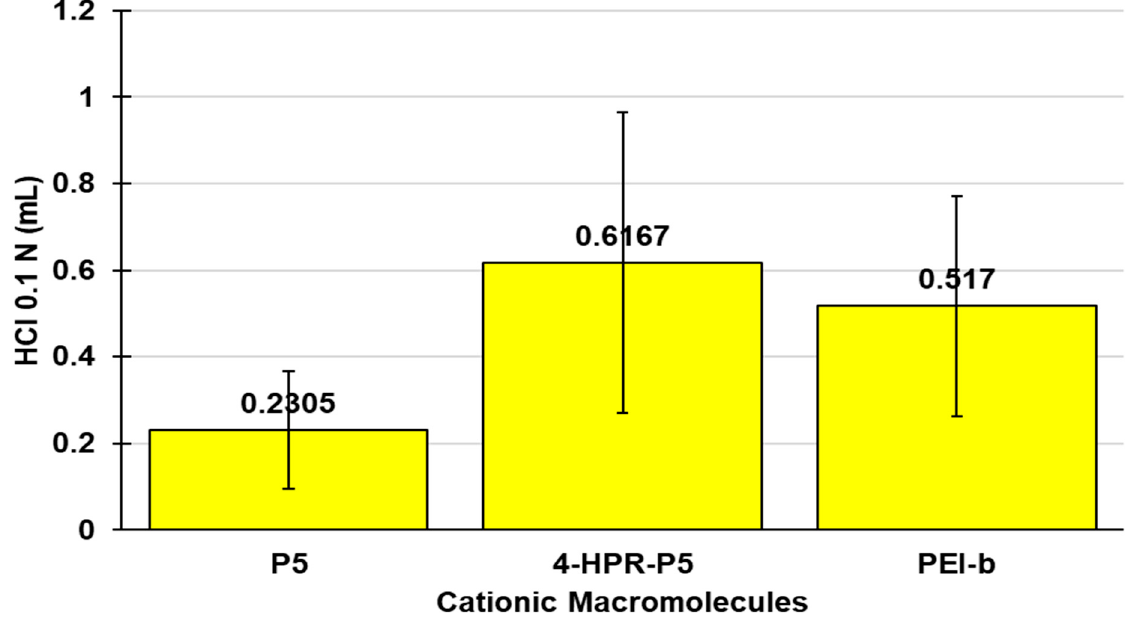
Figure 5. Average buffer capacity of P5, 4-HPR-P5, and PEI- b 25 kD.